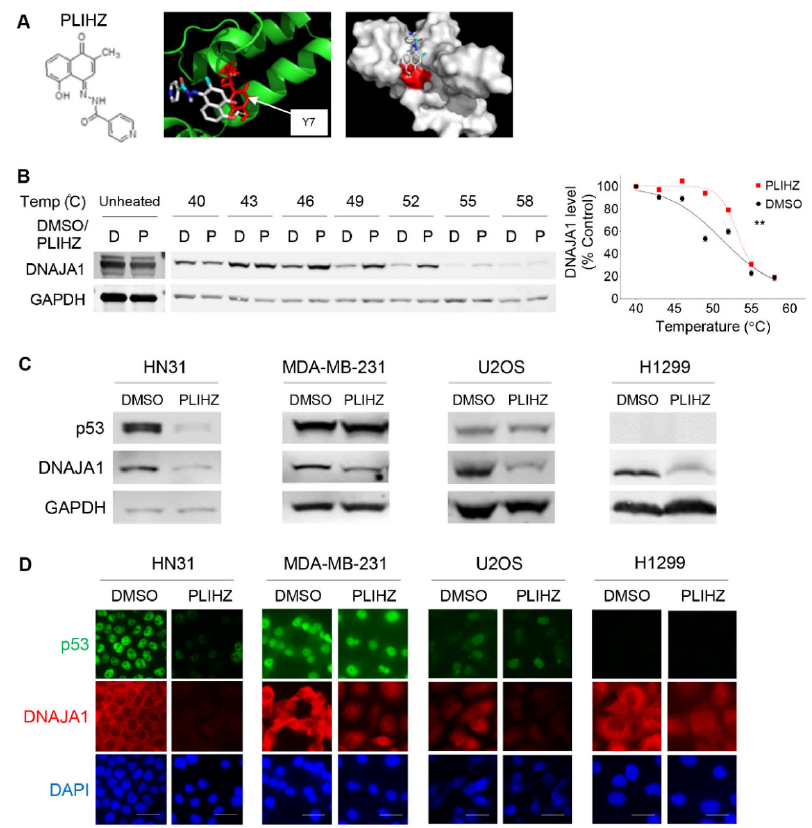
Figure 2. Identification of a compound that binds DNAJA1 to specifically reduce conformational mutp53. ( A ) Chemical structure of PLIHZ compound, derived from plumbagin, which was identified through a molecular docking ( left ). Ribbon and crystal structures of DNAJA1 protein (PDB: 2LOI) showing binding of DNAJA1 to PLIHZ at tyrosine residue Y7 ( right ) with a 2.6 Å bond distance and binding free energy of −6.6 kcal/mol. ( B ) CETSA showing intracellular binding of PLIHZ to DNAJA1. A representative Western blotting for DNAJA1 and GAPDH using protein extracts from CAL33 (p53 R175H ) cells with treatment with DMSO and PLIHZ at 80 μM for 4 h, followed by incubation at different temperatures for 3 min ( left ). A representative blot using protein extracts from unheated cells are also shown. A summarized graph showing normalized DNAJA1 band den- sities at different temperatures of 40, 43, 46, 49, 52, 55, and 58 °C ( right ). Mean ± SEM from three independent experiments ( n = 3). ** p < 0.01 for two-way ANOVA. ( C ) Western blotting for p53, DNAJA1, and GAPDH using indicated cells with different p53 status, treated with DMSO or PLIHZ at ~1/2 of 24h-IC50 for 24 h. ( D ) Immunofluorescence for p53, DNAJA1, and DAPI using indicated cells treated with DMSO or PLIHZ at ~1/2 of 24h-IC50 for 24 h.